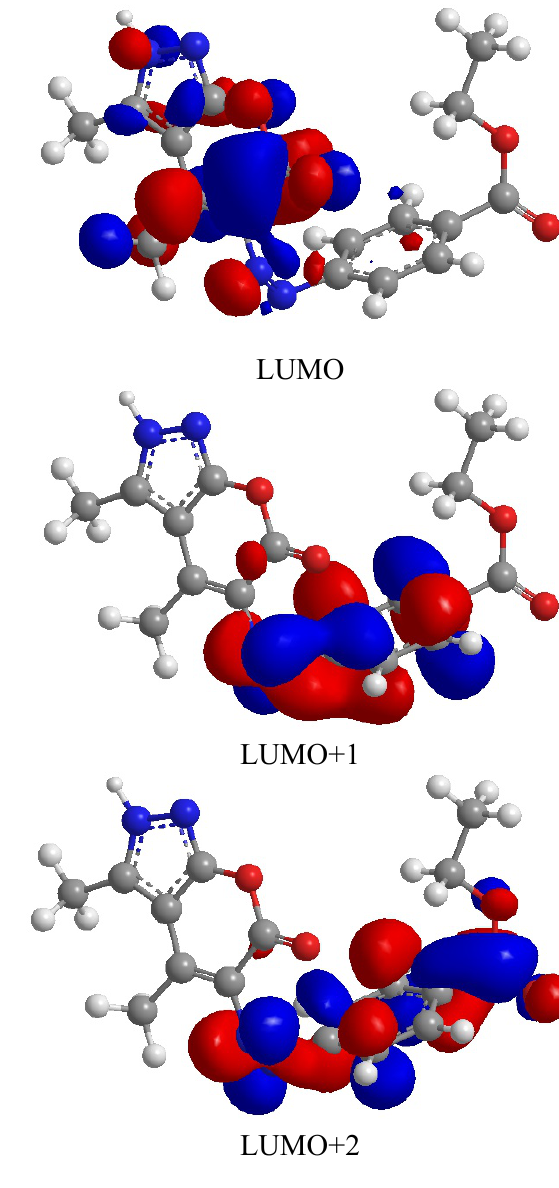
Table 2. HOMO and LUMO energies (eV) of compounds 5 and 8